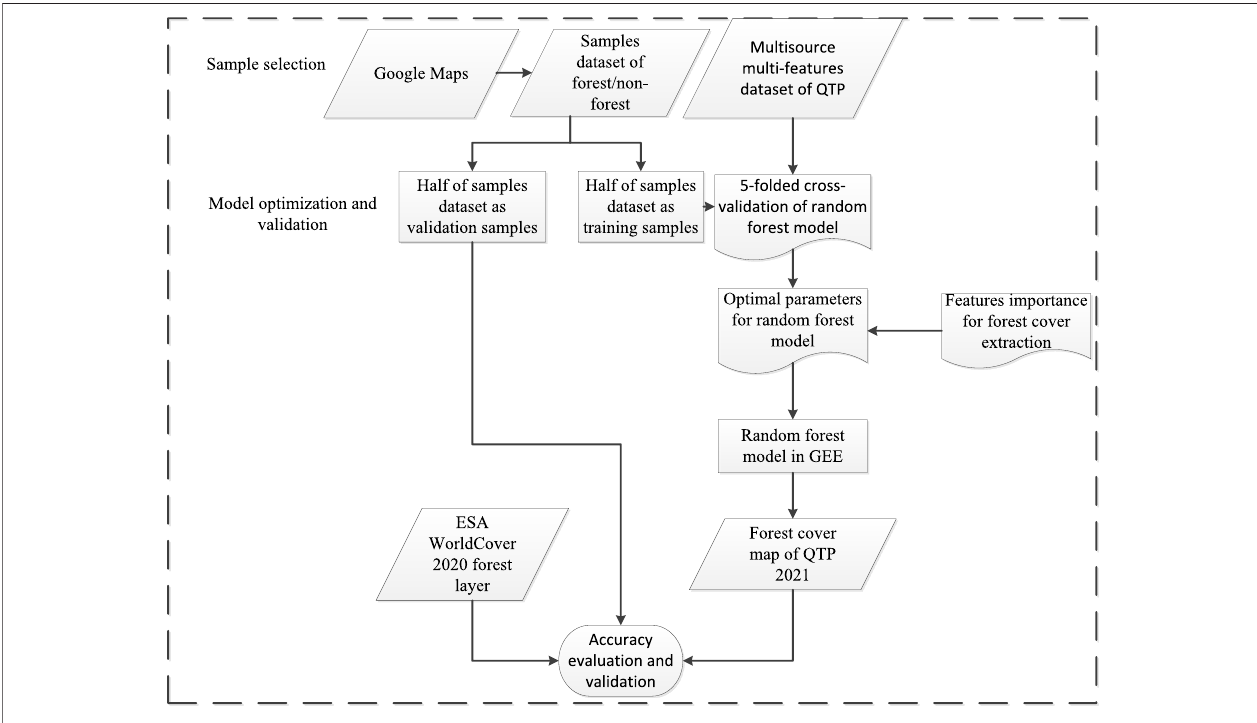
FIGURE 4 | Technical fl owchart of the classi fi cation and validation